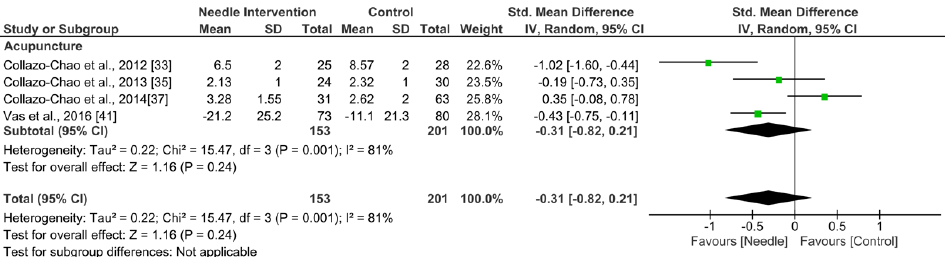
Figure 10. Forest plot for Sleeping Quality after +6 months.